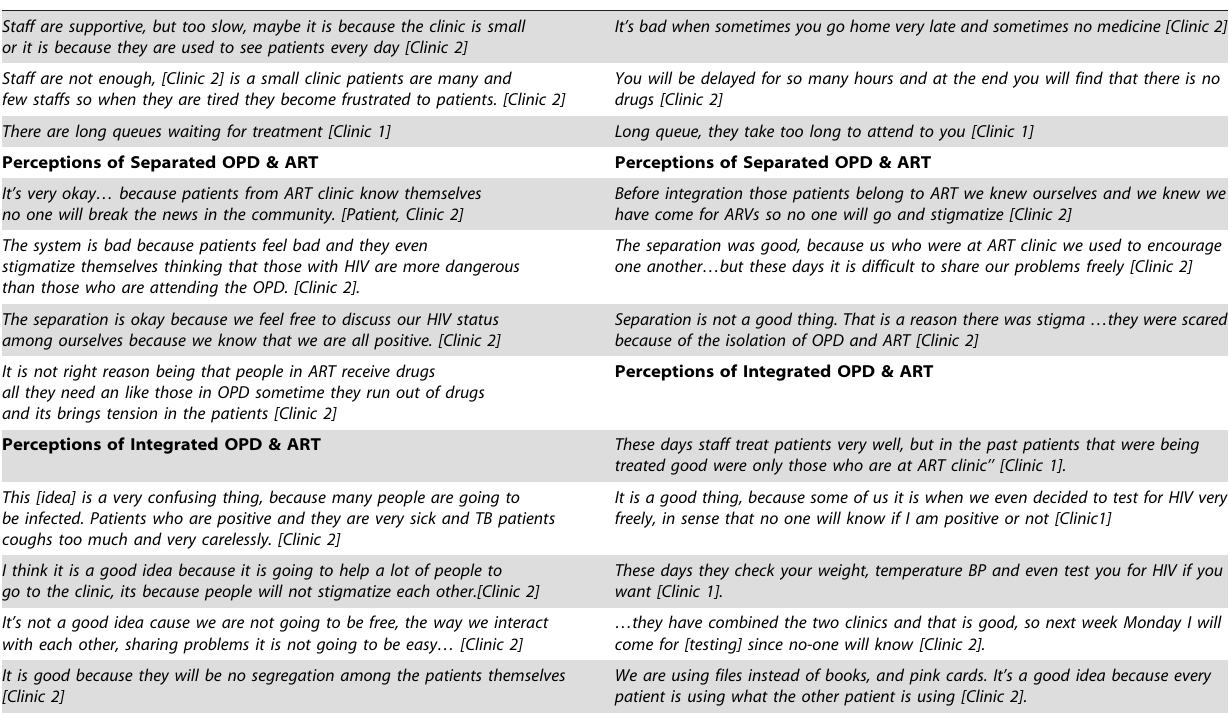
Table 1. Pre- and post-implementation patient